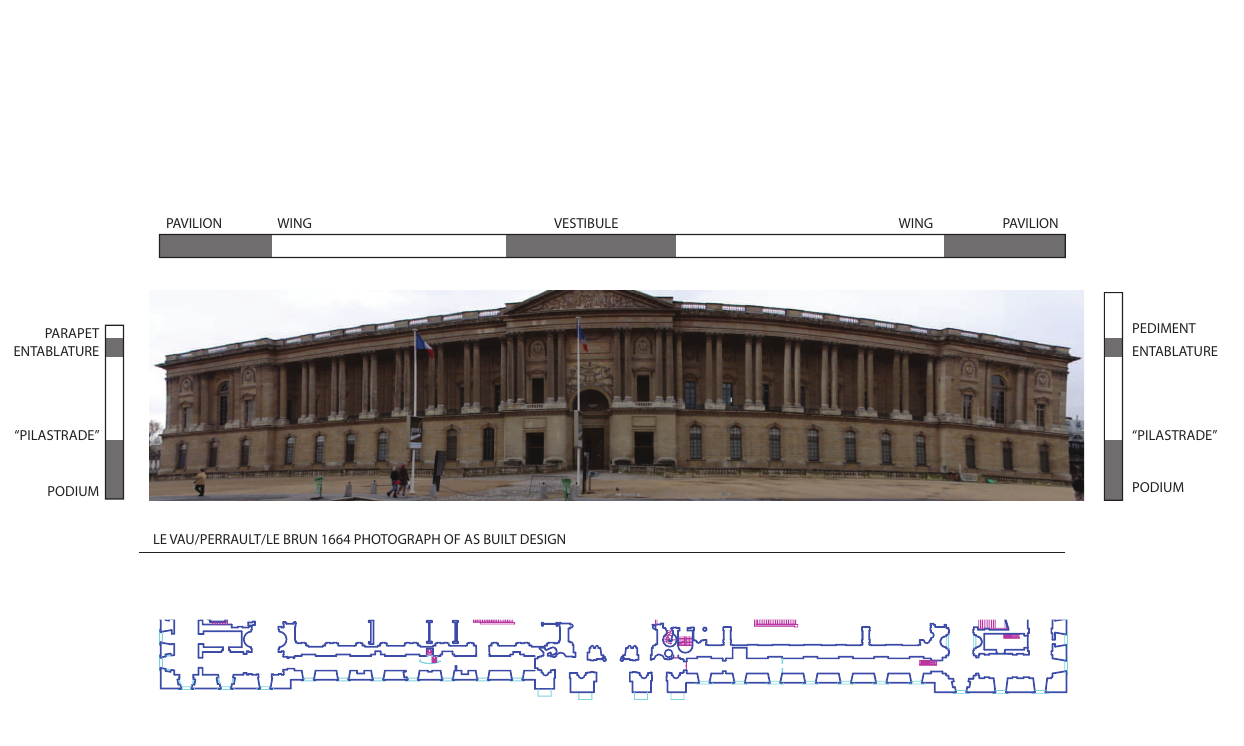
Figure 4: Diagram of Splits for the Le Vau Design of 1662